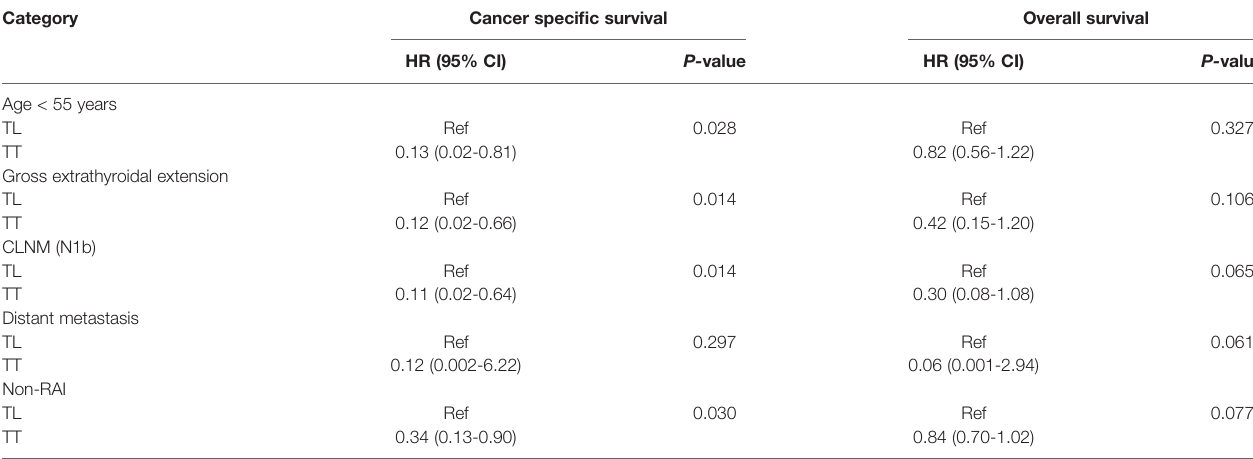
TABLE 3 | The subgroup analysis of the prognosis of PTMC patients treated with TT versus TL by multivariate Cox regression. Category